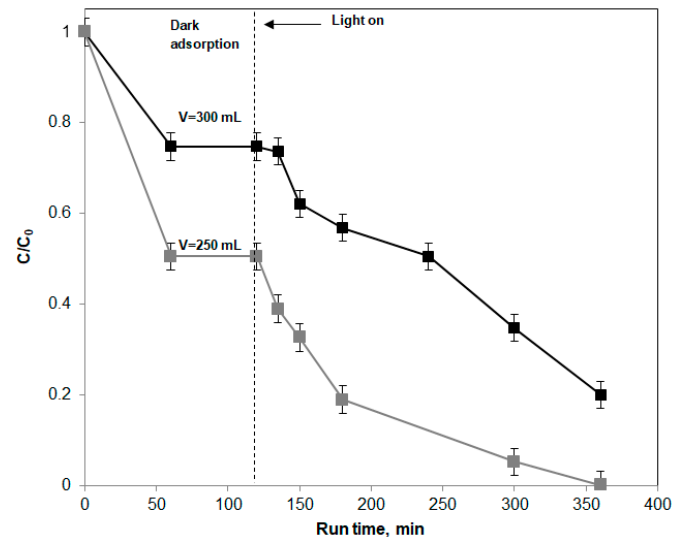
Figure 3. Behavior of urea’s relative concentration as a function of visible light irradiation time obtained with FD LED dimming and with different solution volumes. Urea initial concentration: 250 mg/L; N-TiO 2 /PS amount: 120 g.